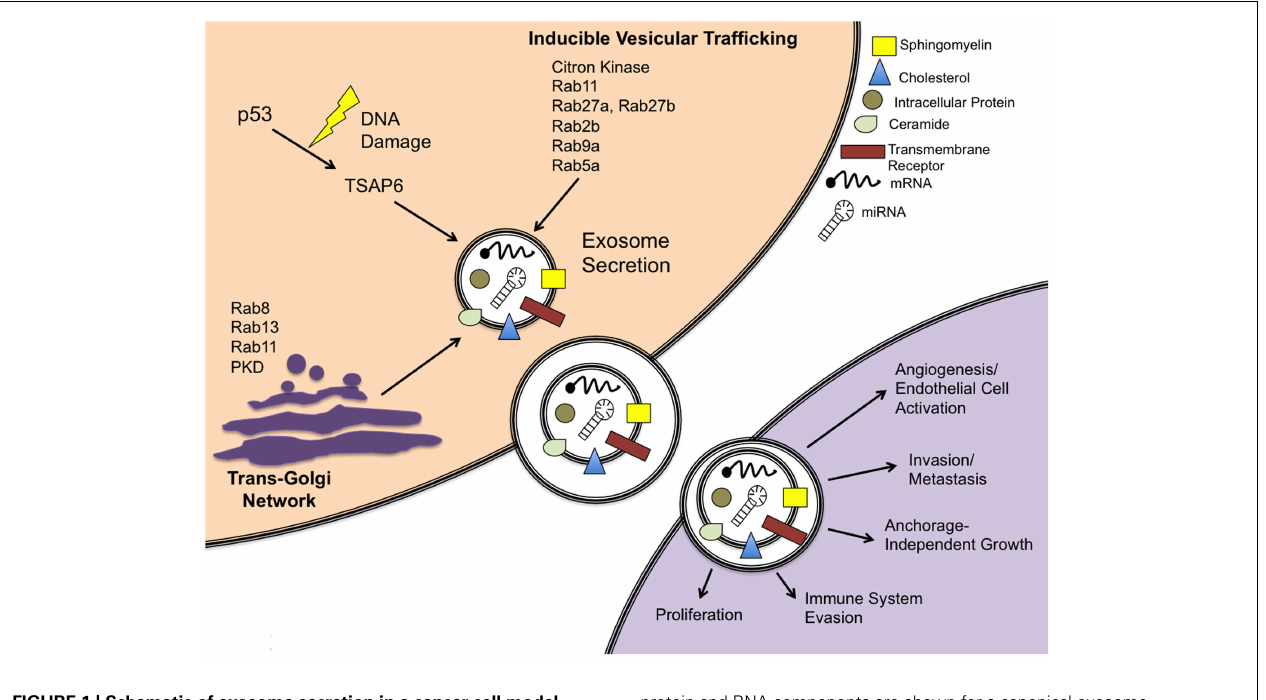
FIGURE 1 | Schematic of exosome secretion in a cancer cell model. Exosomes are secreted via a constitutive pathway involving theTrans-Golgi Network and/or inducible pathways, which can be activated by a p53-mediated response to DNA damage or Rab GTPases. Characteristic